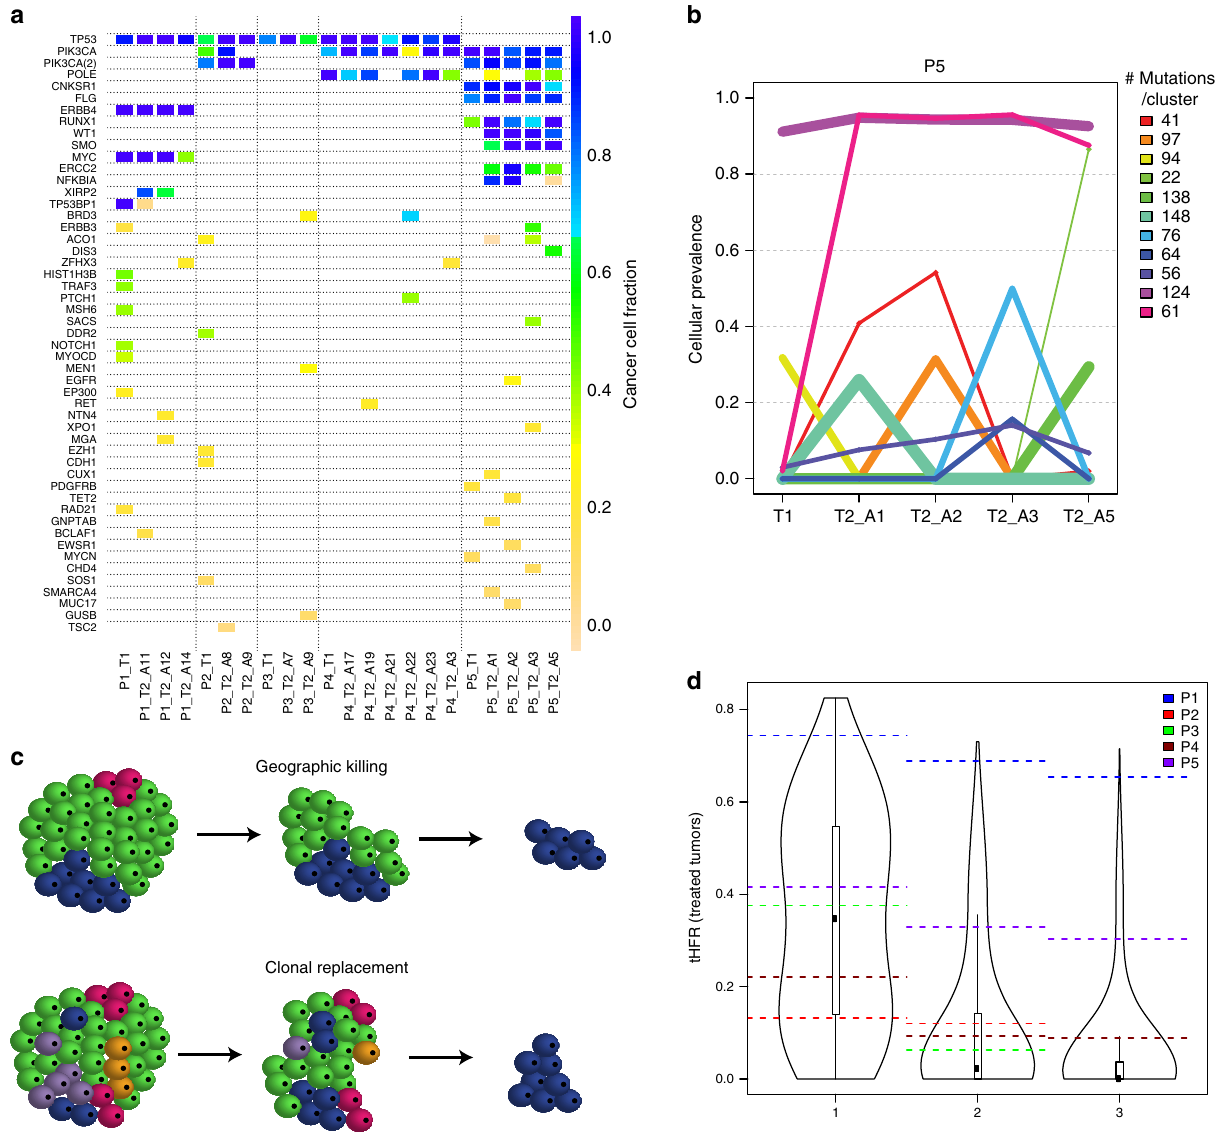
Fig. 3 Intra-tumor heterogeneity and clonal replacement in treated primary breast tumors. a Heterogeneity of protein-altering mutations in driver and targetable genes pre- and post-treatment, with multi-region sampling. b Cellular prevalence of inferred mutational clusters across treatment in P5 (PyClone). T1 is pre-treatment and T2 is post-treatment. The purple cluster re fl ects truncal mutations and the pink cluster re fl ects a new clone arising post- treatment. c Schematic describing geographic killing and clonal replacement. Untreated primaries must have regions of high homogeneity for geographic killing to mimic clonal replacement. d Values of tHFR in patient-treated tumors (dashed lines) compared to distributions of tHFR in virtual untreated tumors. For each case, tHFR is computed using 1, 2, and, when possible, 3 post-treatment samples (averaged over all possible combinations of subsets of post-treatment samples) to compare to the distribution derived from the virtual tumors for 1, 2, and 3 post-treatment samples. tHFR corresponds to the percentage of clonal mutations across all post-treatment samples that are absent or rare in a single pre-treatment sample. P1 and P5 exhibited tHFR values consistent with clonal evolution (not geographic killing). In certain cases, at least two post-treatment samples were necessary to discriminate between pre- treatment heterogeneity (P3) and clonal evolution (P5), as demonstrated within the simulation framework. Source data for panels a , b , and d are